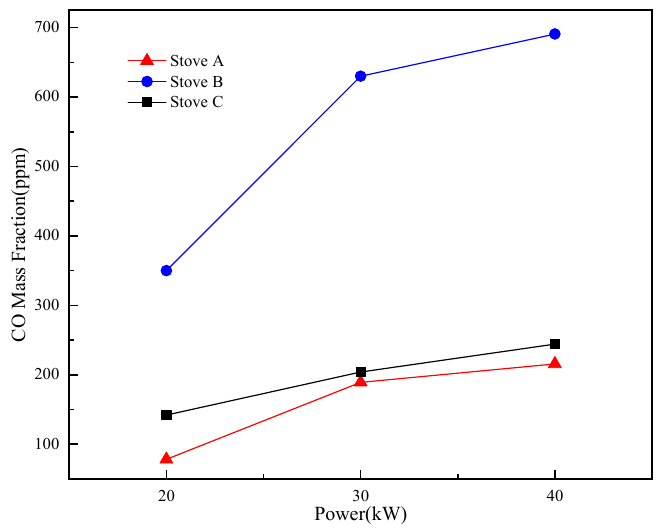
Figure 12. CO mass fraction of the three stoves at different power rates.